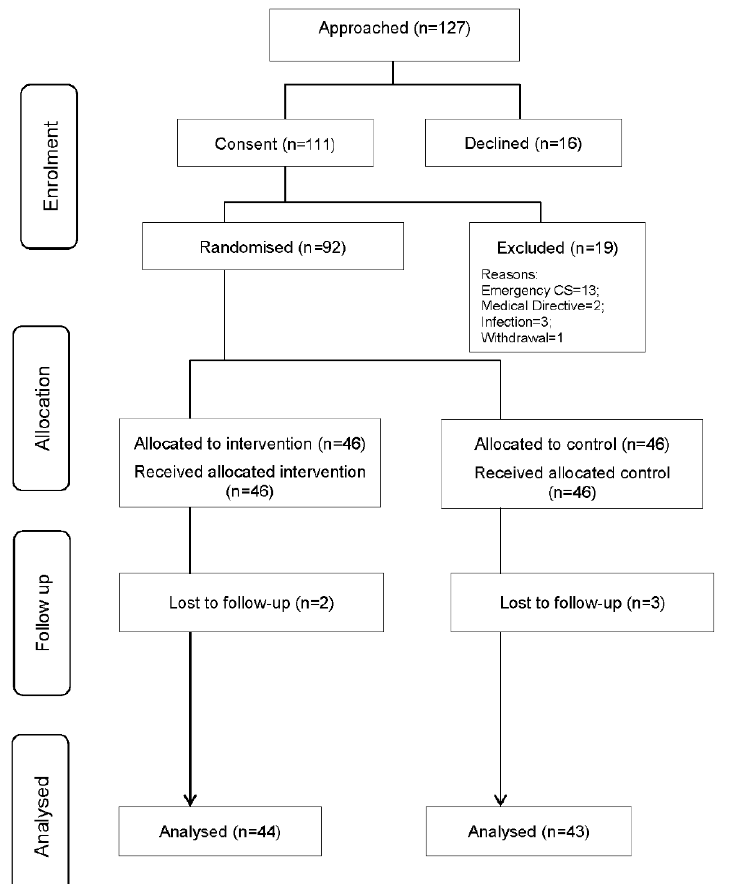
Figure 1. Participant Flow